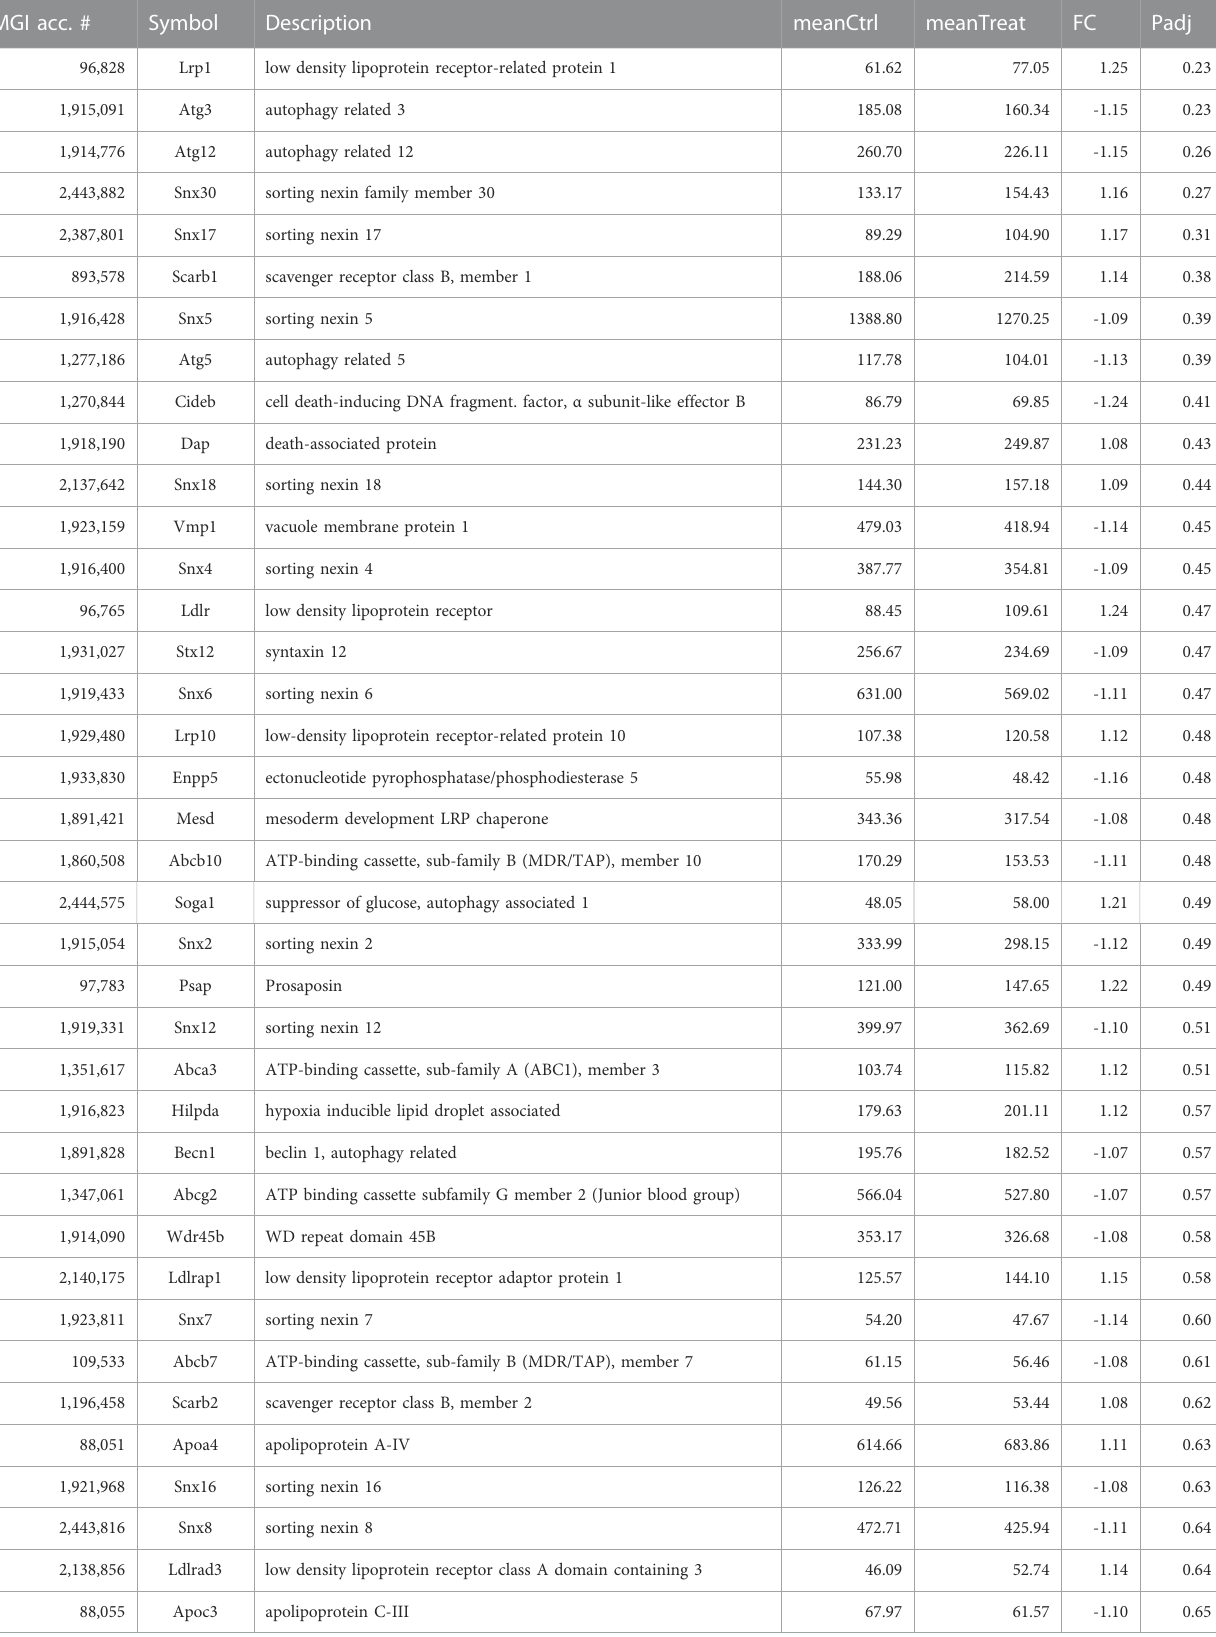
TABLE 1 Expression levels of genes with relevance to lipid transport and processing. MGI acc.